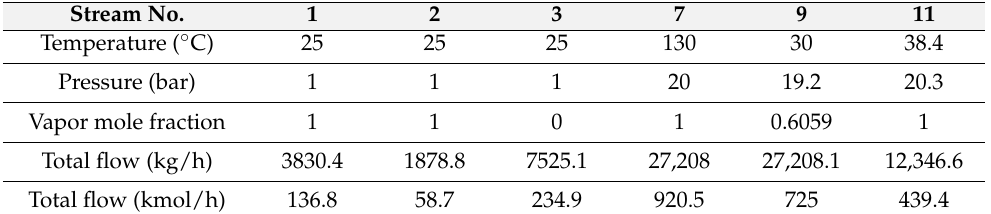
Table 3. Stream information of the DMC and DMO coproduction